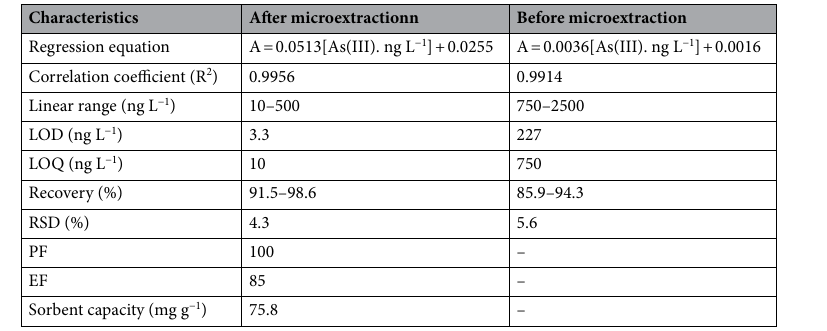
Table 4 . Analytical performance characteristics.